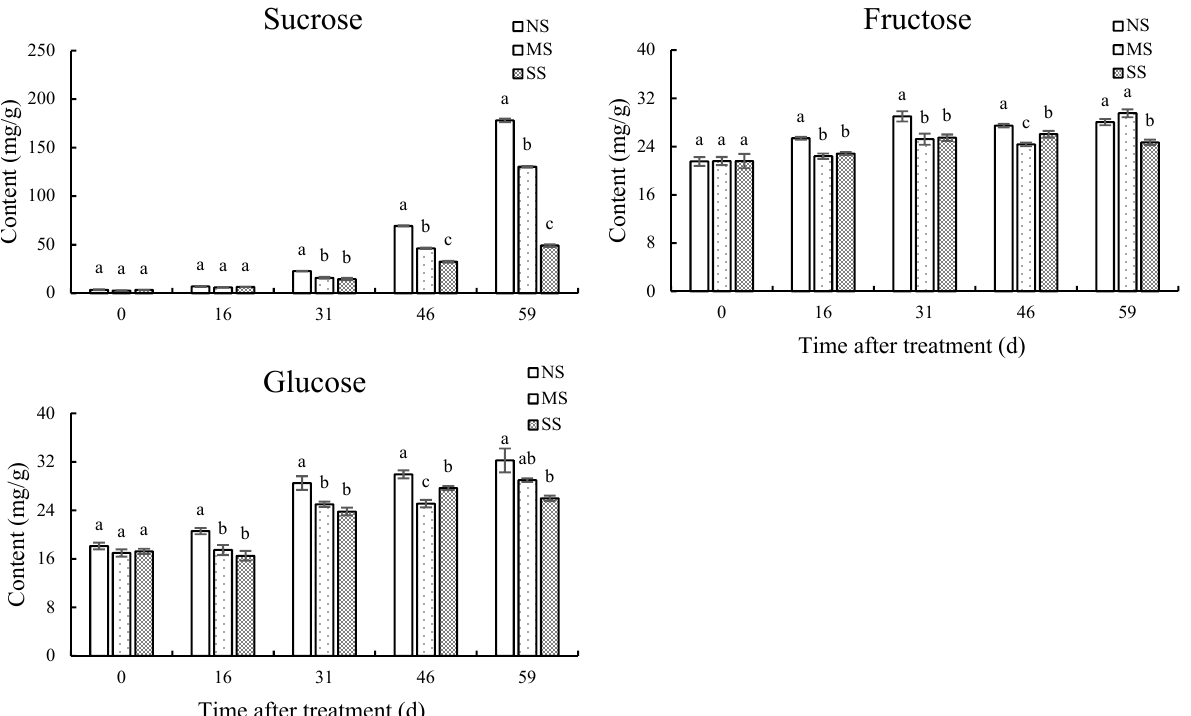
Figure 3. Dynamic changes in soluble sugar contents in fruits. ( A ) Sucrose content. ( B ) Fructose content. ( C ) Glucose content. Values are means of three replicates ± SD and different letters indicate significant differences (Duncan (cid:48) s multiple range tests, p < 0.05) among three treatments at the same developmental